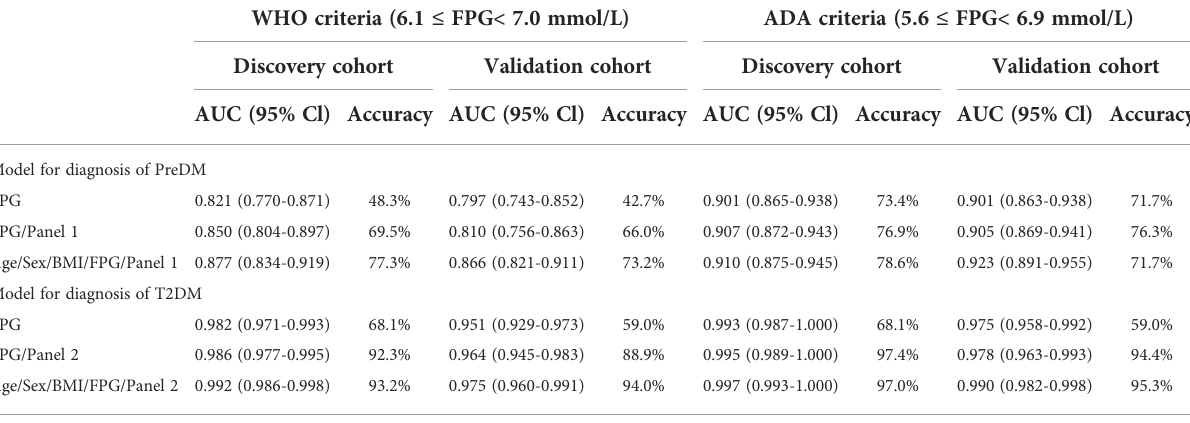
TABLE 4 AUC and accuracy for diagnosis of PreDM and T2DM in the discovery and validation